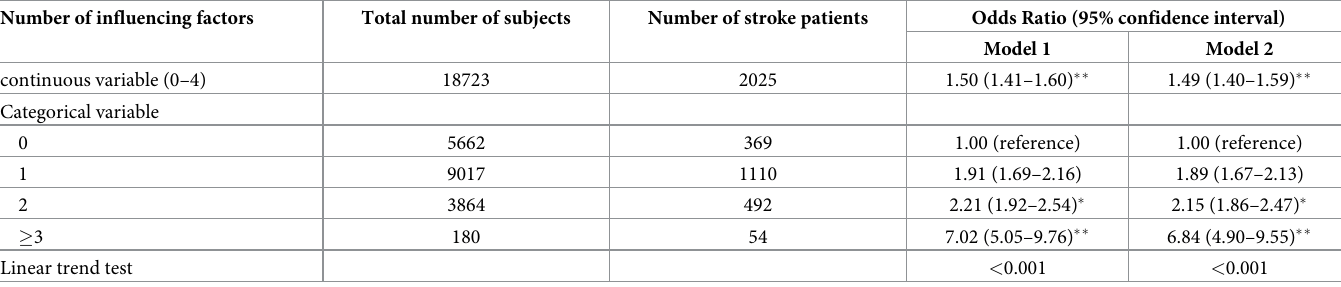
Table 3. The analysis result of the relationship between the number of influencing factors and the prevalence of stroke.